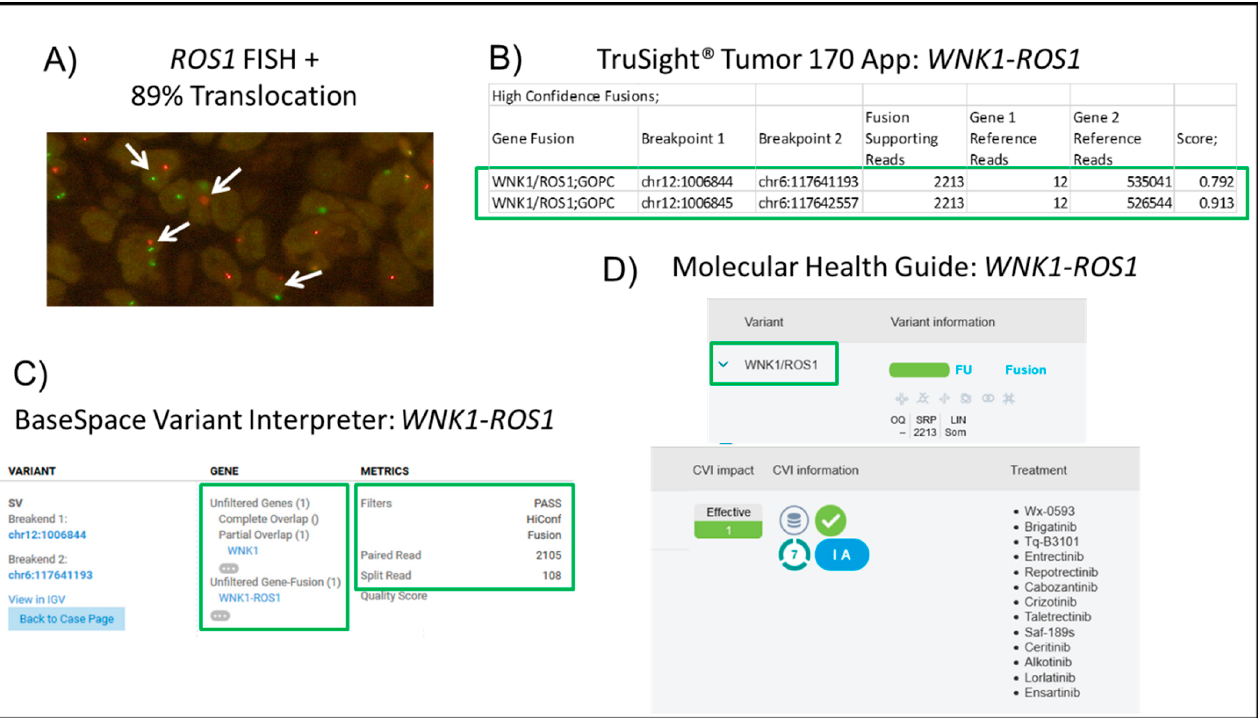
Figure 3. Sample 7 with a ROS1 translocation detected by ROS1 FISH ( A ), sequenced with the TruSight Tumor assay and analyzed with the TruSight Tumor 170 app ( B ) on BaseSpace Sequence Hub and the BaseSpace Variant Interpreter ( C ) as well as the Molecular Health Guide Software ( D ). The amplification and the quality criteria are highlighted with a green rectangle for each software.